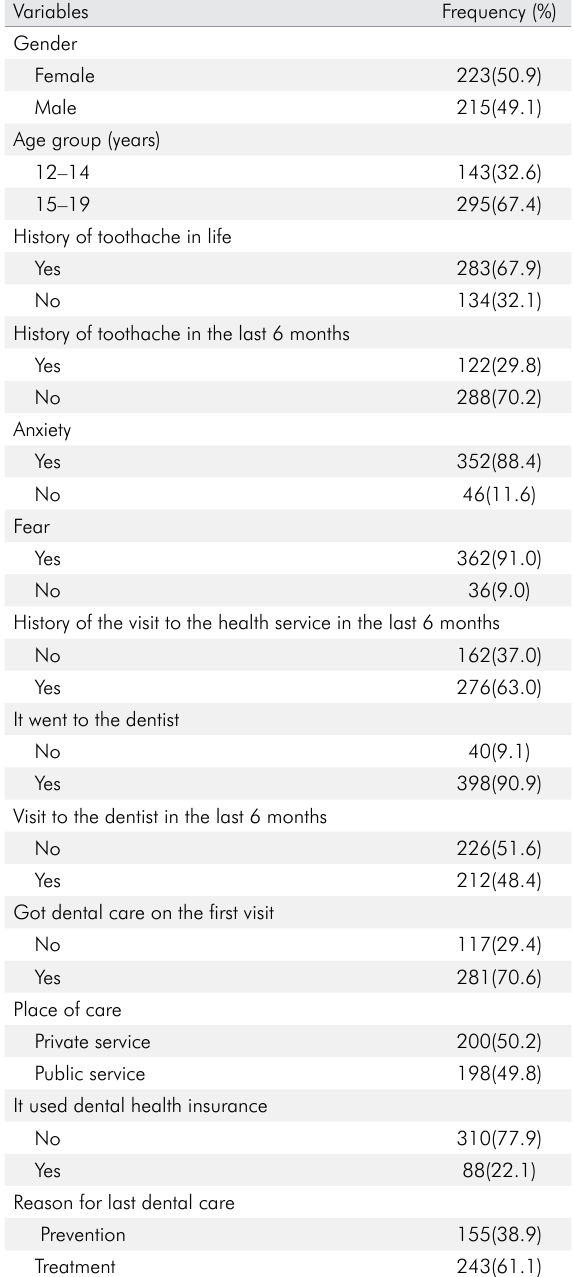
Table 1. Frequency of access to health services and their characteristics among adolescents in public schools. Campina Grande,